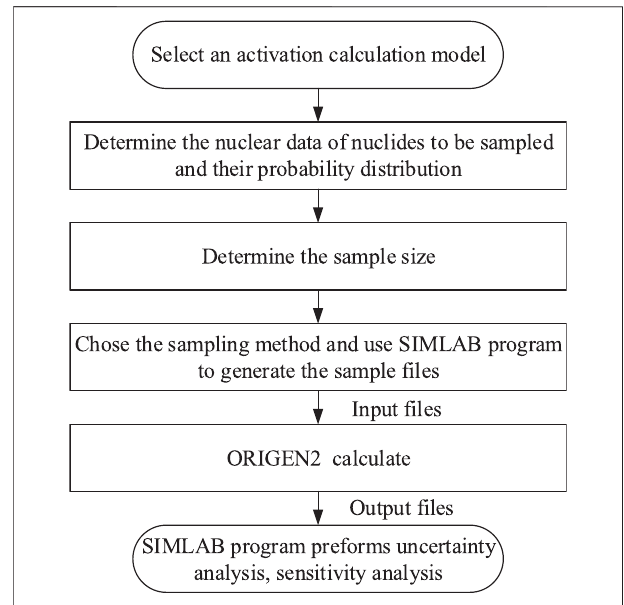
FIGURE 3 | Calculation fl owchart of the uncertainty method.